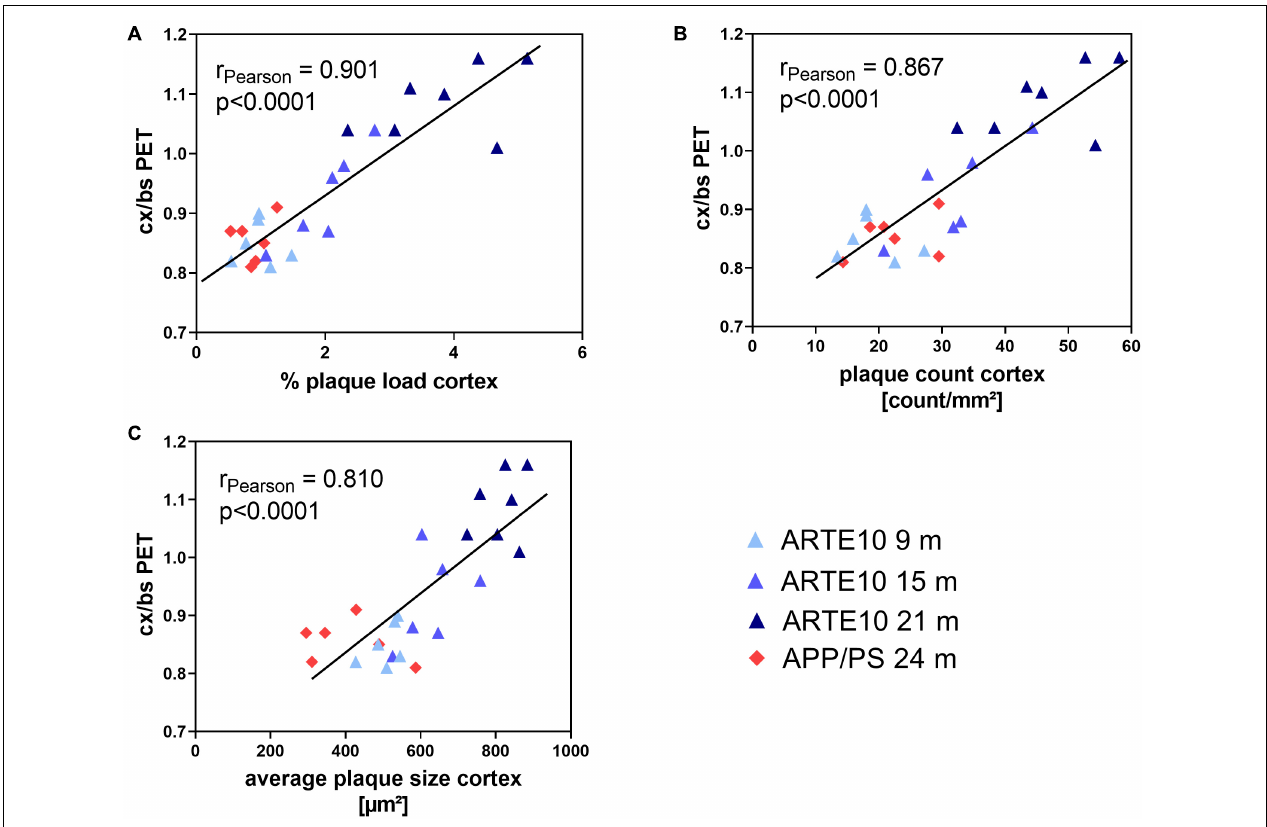
FIGURE 6 | Correlation between ex vivo histological amyloid plaque pathology and in vivo amyloid load as determined by PET analysis. Plaque load (A) , number (B) , and average size (C) of amyloid plaques in the cortex as quantified using Congo red–stained brain slices from 24-month-old APPswe/PS1 (cid:49) E9 (APP/PS) and ARTE10 mice of different ages (9–21 months) are correlated with SUVR of FBB retention in the cortex referenced to the brain stem (cx/bs). Each data point represents the value of a single animal. Pearson correlation coefficient r and p -values of the statistical analysis are given for each data set.